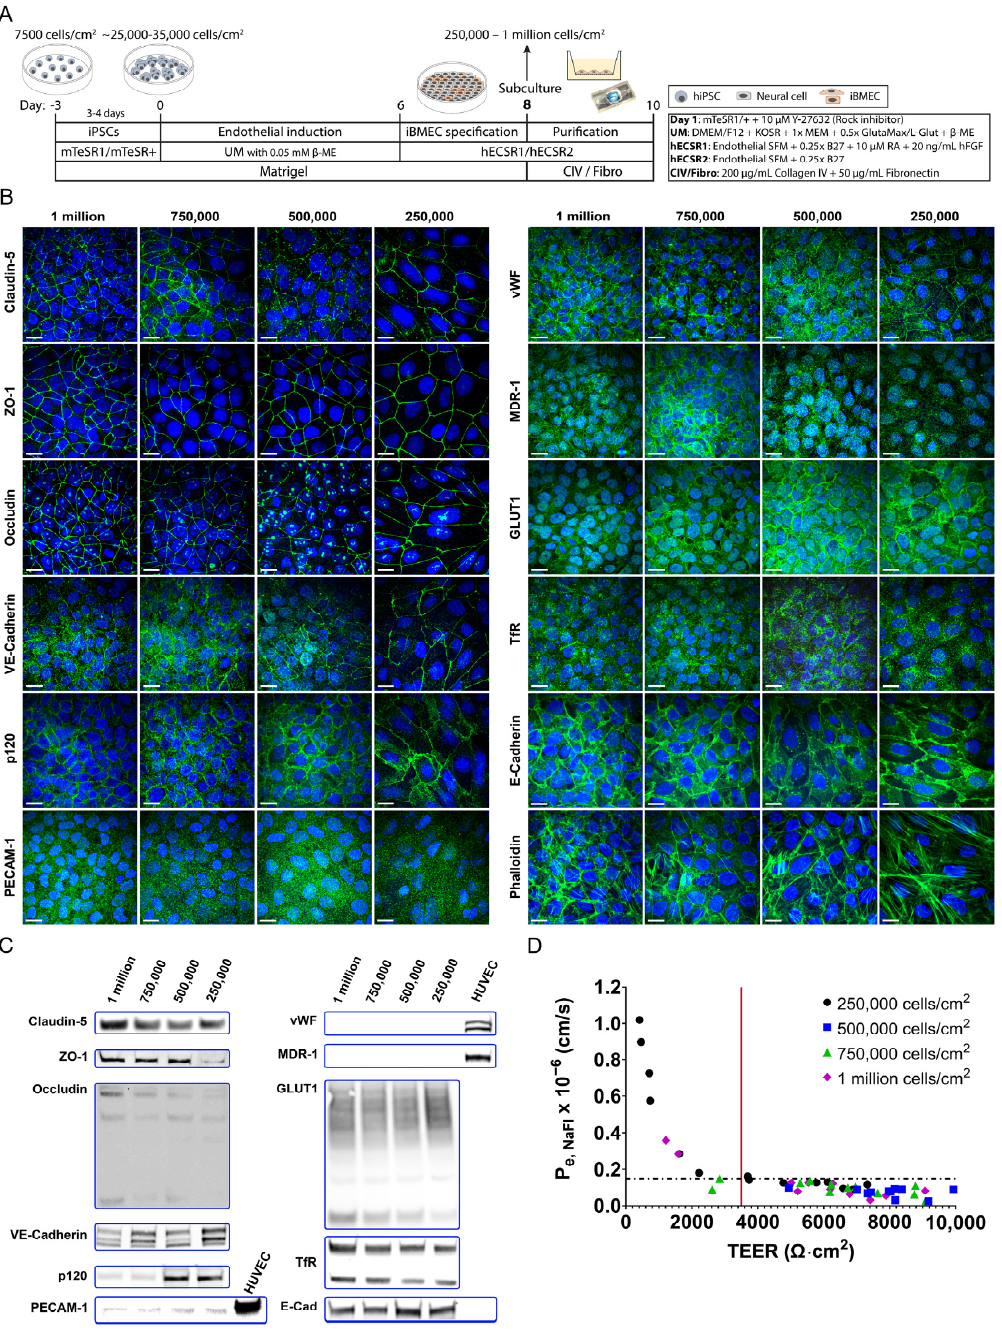
Figure 1. IMR90-4 hiPSC-derived iBMECs with different plating concentrations exhibit optimal barrier properties with some epithelial characteristics on ThinCert ® membranes. ( A ) Schematics of the final differentiation protocol for deriving iBMECs from IMR90-4 hiPSCs. The iBMEC-neuronal cell culture mix was subcultured on day 8 using four different plating densities, and the purified iB- MECs were characterised or used on day 10 or day 11. ( B ) Representative maximum intensity pro- jection (MIP) confocal images showing the expression of junctional proteins (Claudin-5, ZO-1, Oc- cludin, VE-Cadherin, and p120), the lack/not correctly localised expression of PECAM-1 and endo- thelial markers (vWF, MDR-1 (P-glycoprotein 1) efflux transporter, GLUT1 glucose transporter, and TfR), E-Cadherin epithelial marker, and phalloidin. Markers: green, Hoechst 33,342 nuclei stain: blue. Scale bars represent 20 µm. 1 million, 750,000, 500,000, and 250,000 represent the plating den- sities in cells/cm 2 . ( C ) Western blot analysis shows the expression of endothelial markers. A slight